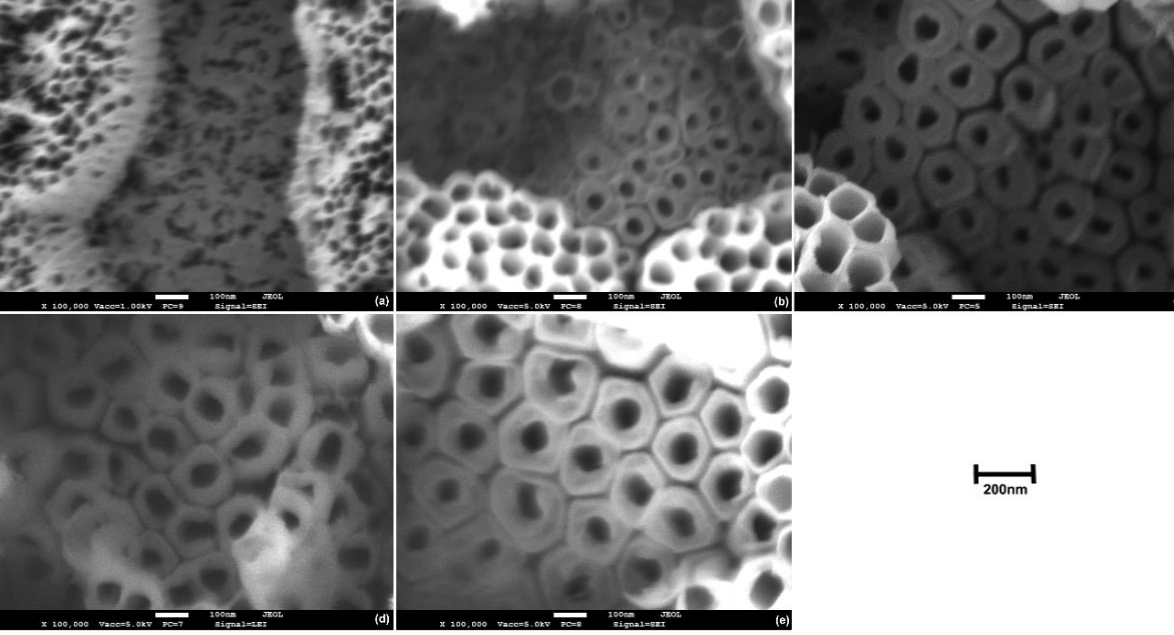
Figure 5. High magnification FESEM micrographs depicting a top-view of the anodic oxide layer produced over the β -phase through electrochemical anodization for 60 min at ( a ) 20 V, ( b ) 40 V, ( c ) 60 V, ( d ) 80 V, and ( e ) 100